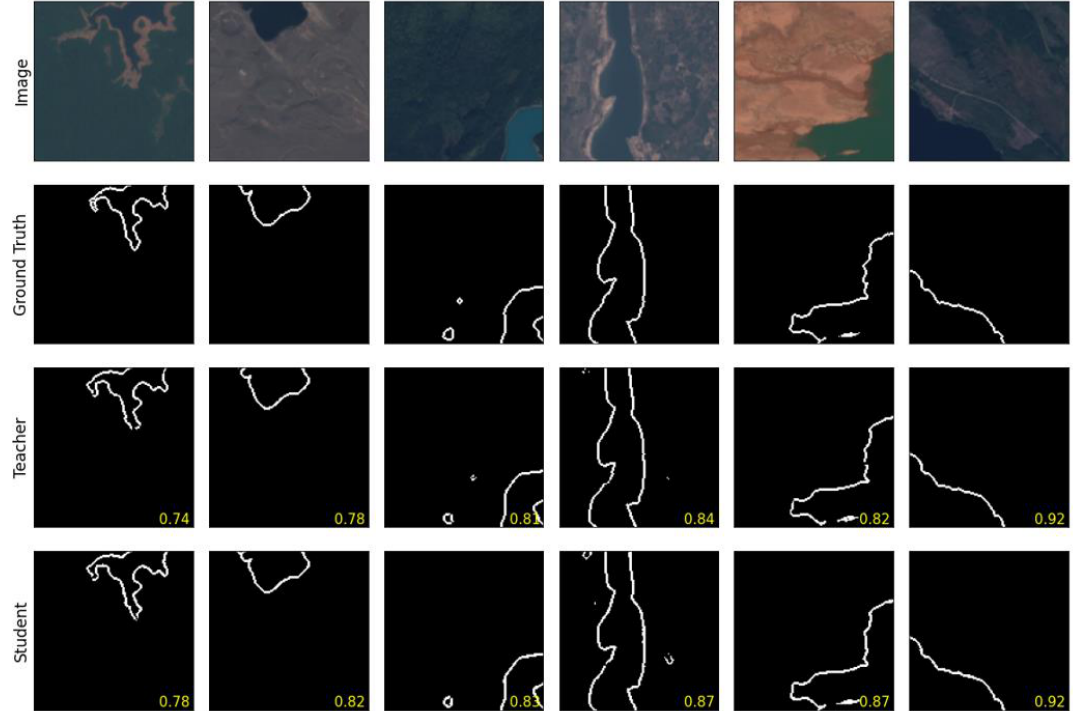
Figure 3. Results on Sentinel data. The rows are RGB image, ground truth, teacher model’s prediction, and student model’s prediction. The F-score for an individual image can be in the bottom right